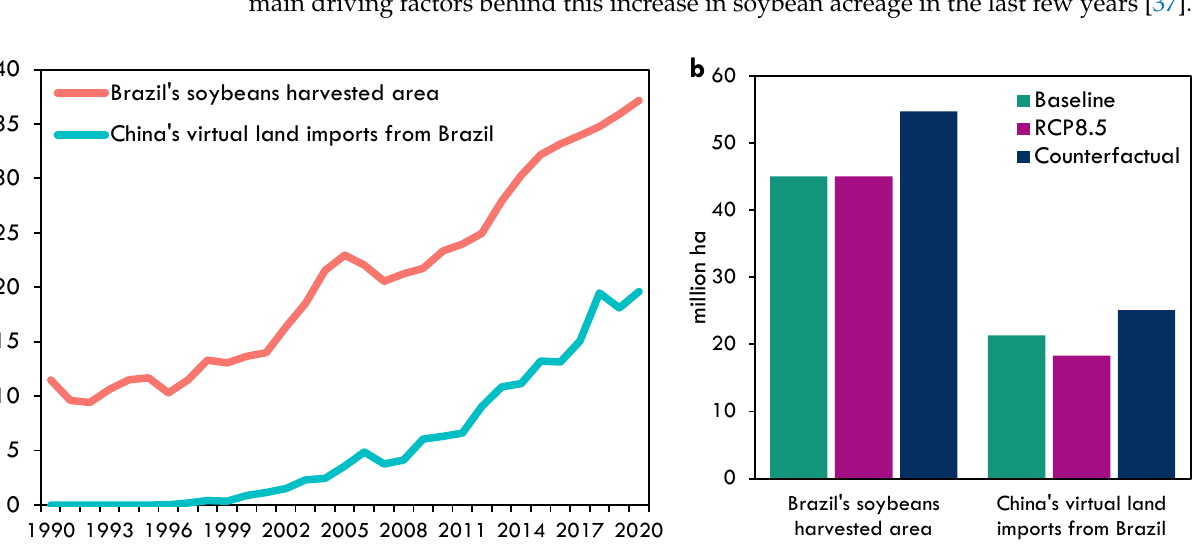
Figure 4. Brazil’s soybean harvested area and China’s virtual land imports from Brazil through soybean import . ( a ) Historical evolution. ( b ) Future projections under baseline, RCP8.5, and a counterfactual scenario. Source: Brazil’s soybean harvested area from FAO [9]; China’s virtual land imports from Brazil through soybean import are our estimations based on data from FAO [9].